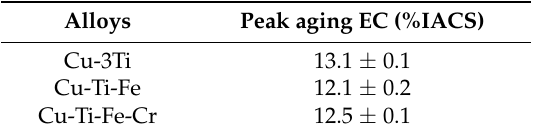
Table 2. Electrical conductivities of the three alloy foils, in the peak-aged